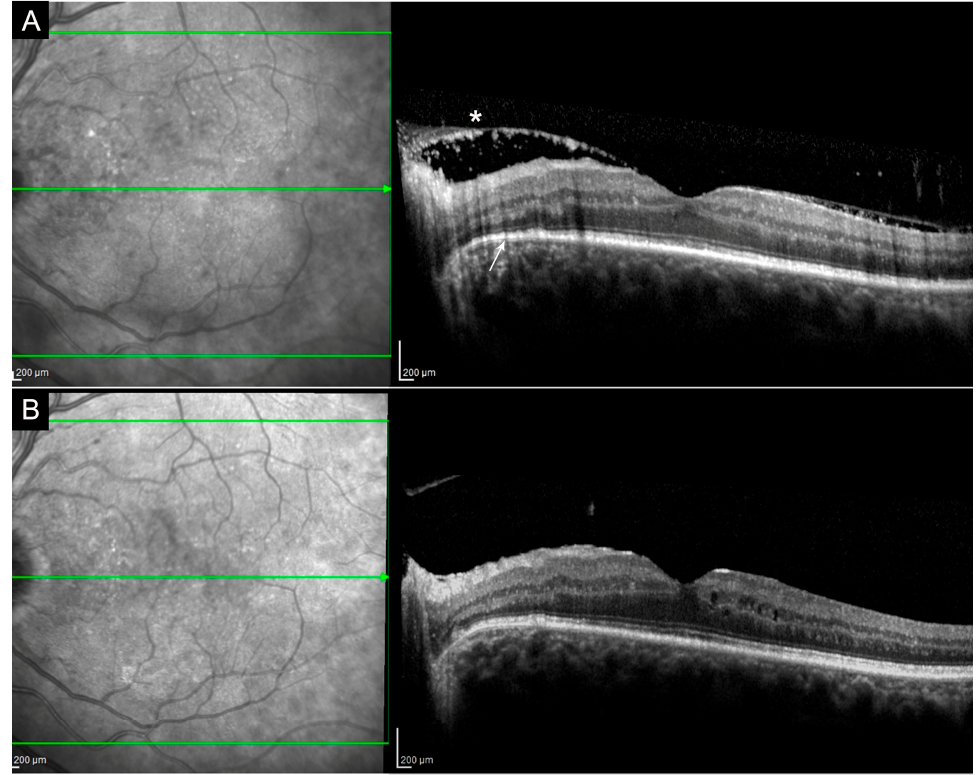
Figure 2. Follow-up OCT scans ( A ) showing multiple superficial pre-retinal aggregates ( asterisk ) and ellipsoid zone disruption ( arrow ) that solve after antibiotic therapy ( B ). Pre-retinal aggregates probably correspond to a combination of spirochetes and inflammatory cells. Ellipsoid zone disruption is probably caused by an accumulation of lipofuscin, inflammatory cells or incomplete phagocytosis of outer retinal segments.